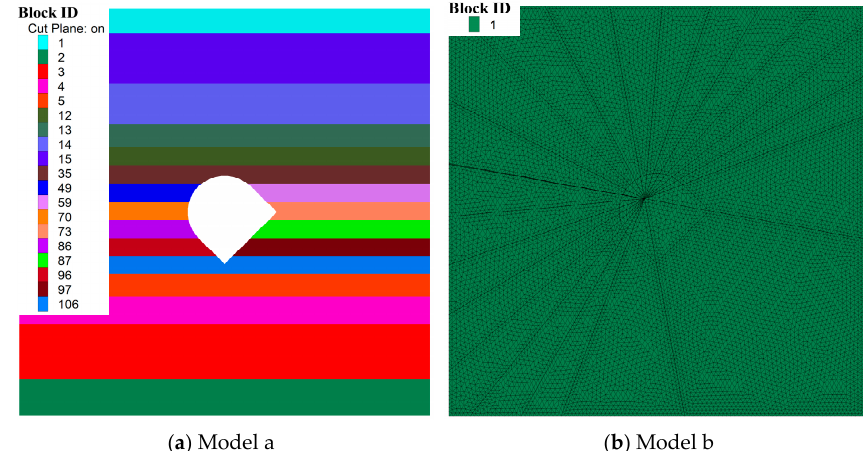
Figure 8. The numerical simulation